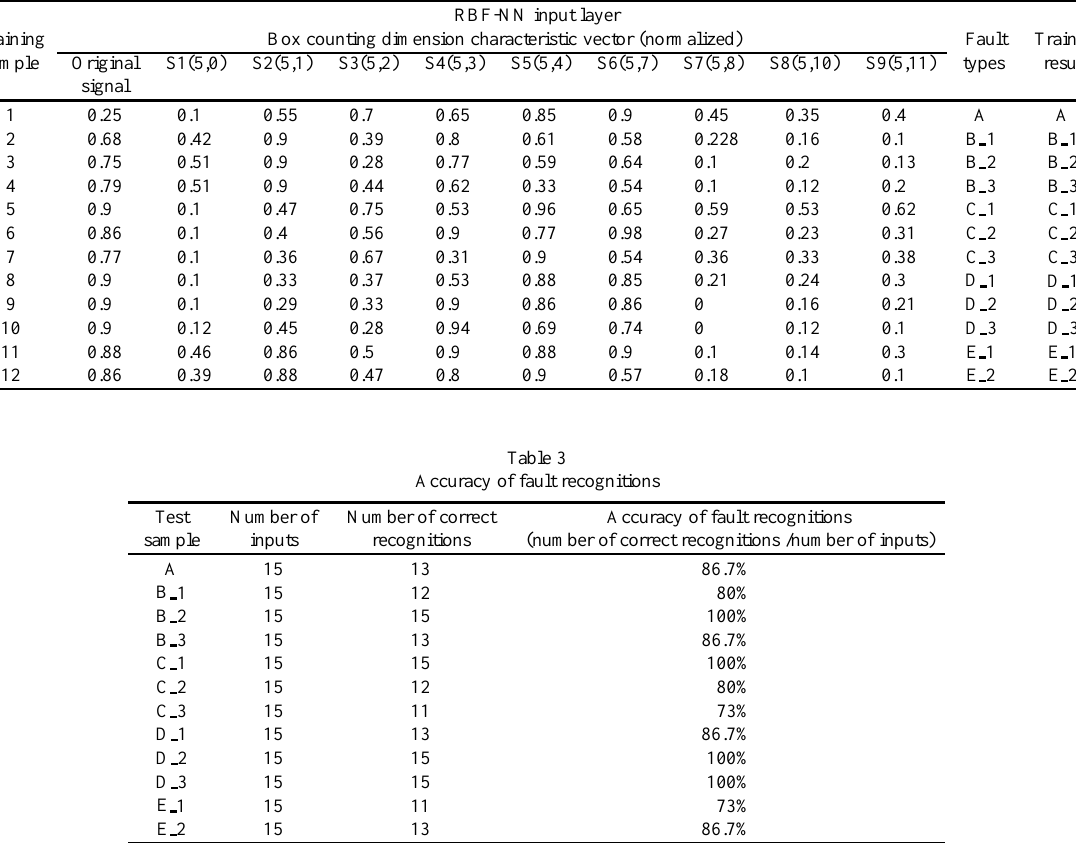
Table 2 Results of RBF-NN training and learning